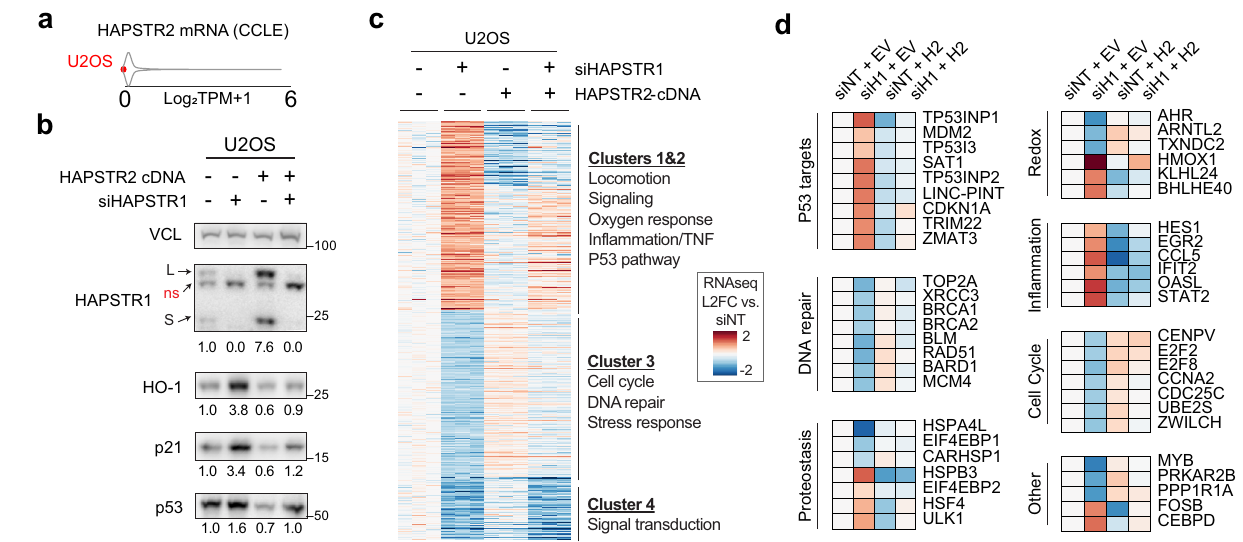
Fig.5|HAPSTR2augmentsandbuffersstresssignaling.a Plotillustratinglow(0 TPM) expression of endogenous HAPSTR2 in U2OS cells. CCLE: cancer cell line encyclopedia. b Expression of exogenous HAPSTR2 is suf fi cient to augment and buffer HAPSTR1-dependent stress signaling. Note that HAPSTR1 on immunoblot appears as a long (L) and short (S) isoform with a non-speci fi c (ns) band in